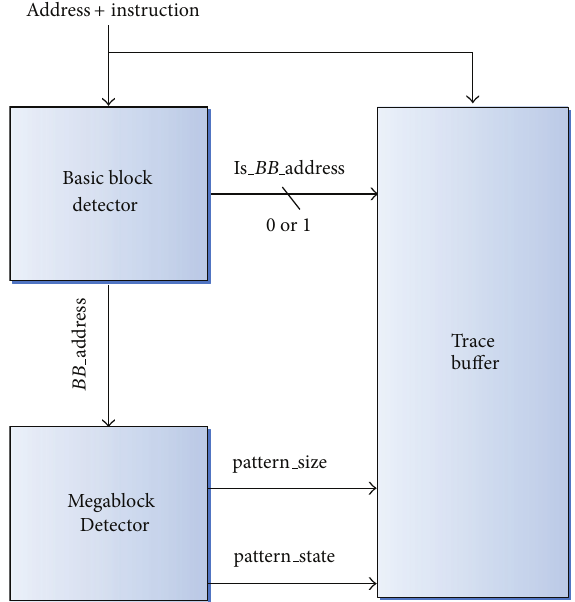
F 2: Hardware solution for Megablock